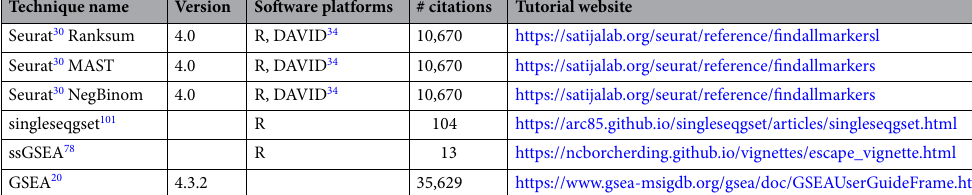
Table 3. Non-AI pathway/geneset enrichment analysis tools.